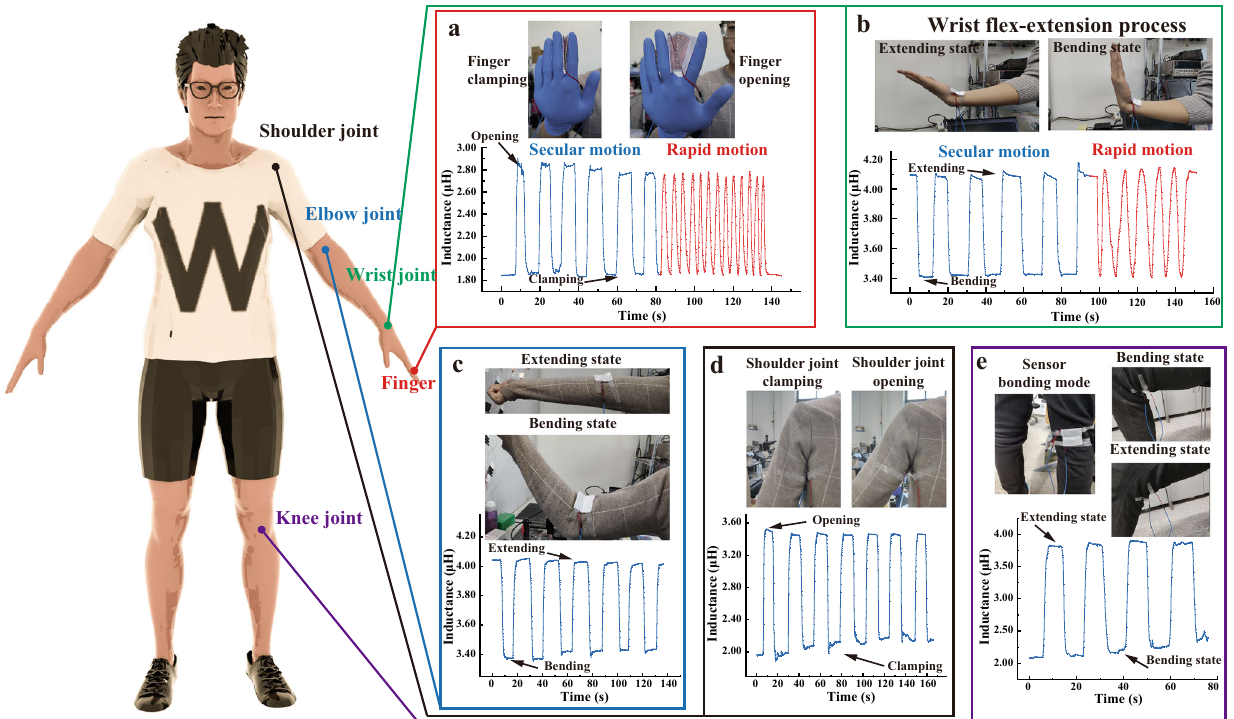
Fig. 8 Application of PSIFS in human motion monitoring. a – e Measurement results of fi nger opening and closing, wrist fl ex-extension, elbow joint rotation, shoulder joint rotation, and knee joint